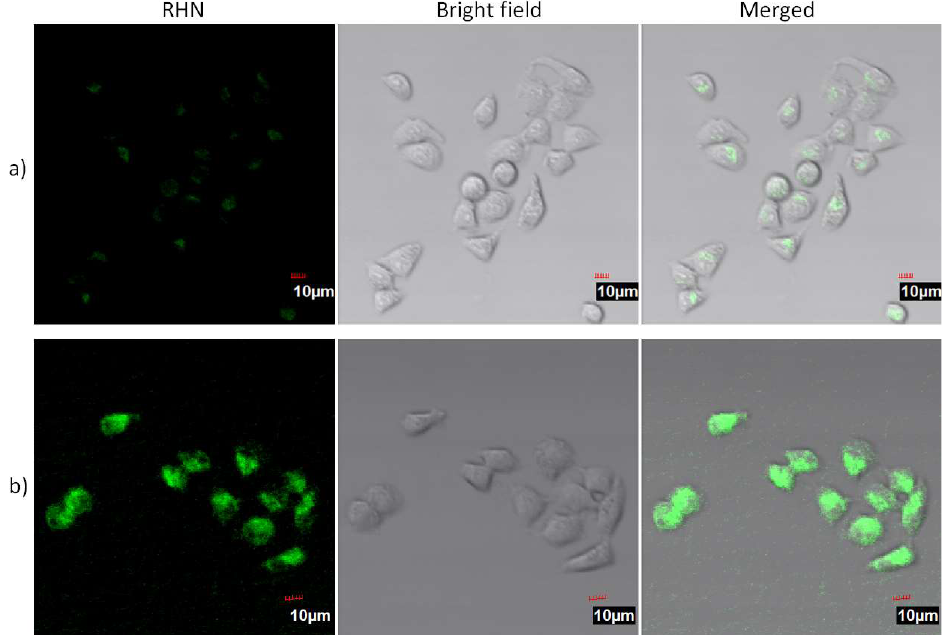
Figure 5. Fluorescence images of HeLa cells. ( a ) Cells were incubated with RHN (1 μM) for 30 min, then ( b ) incubated with OCl − (10 μM) for 30 min. λ ex = 488 nm; λ em = 510–600